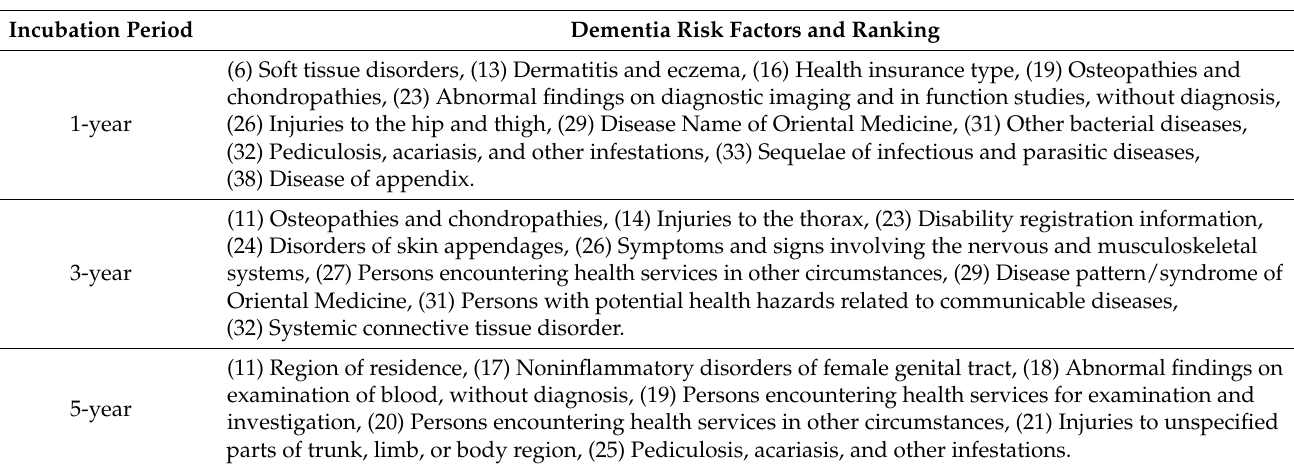
Table 9. Newly identified dementia risk factors by the incubation period model.